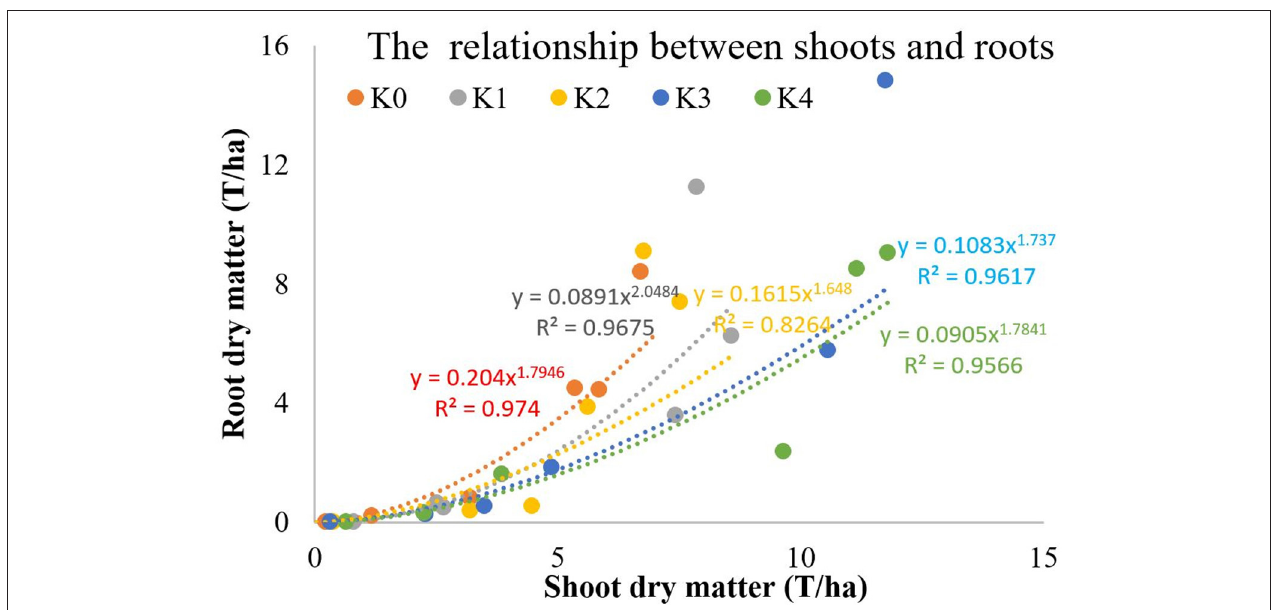
FIGURE 10 | Relationship between shoots and roots under different K fertilization